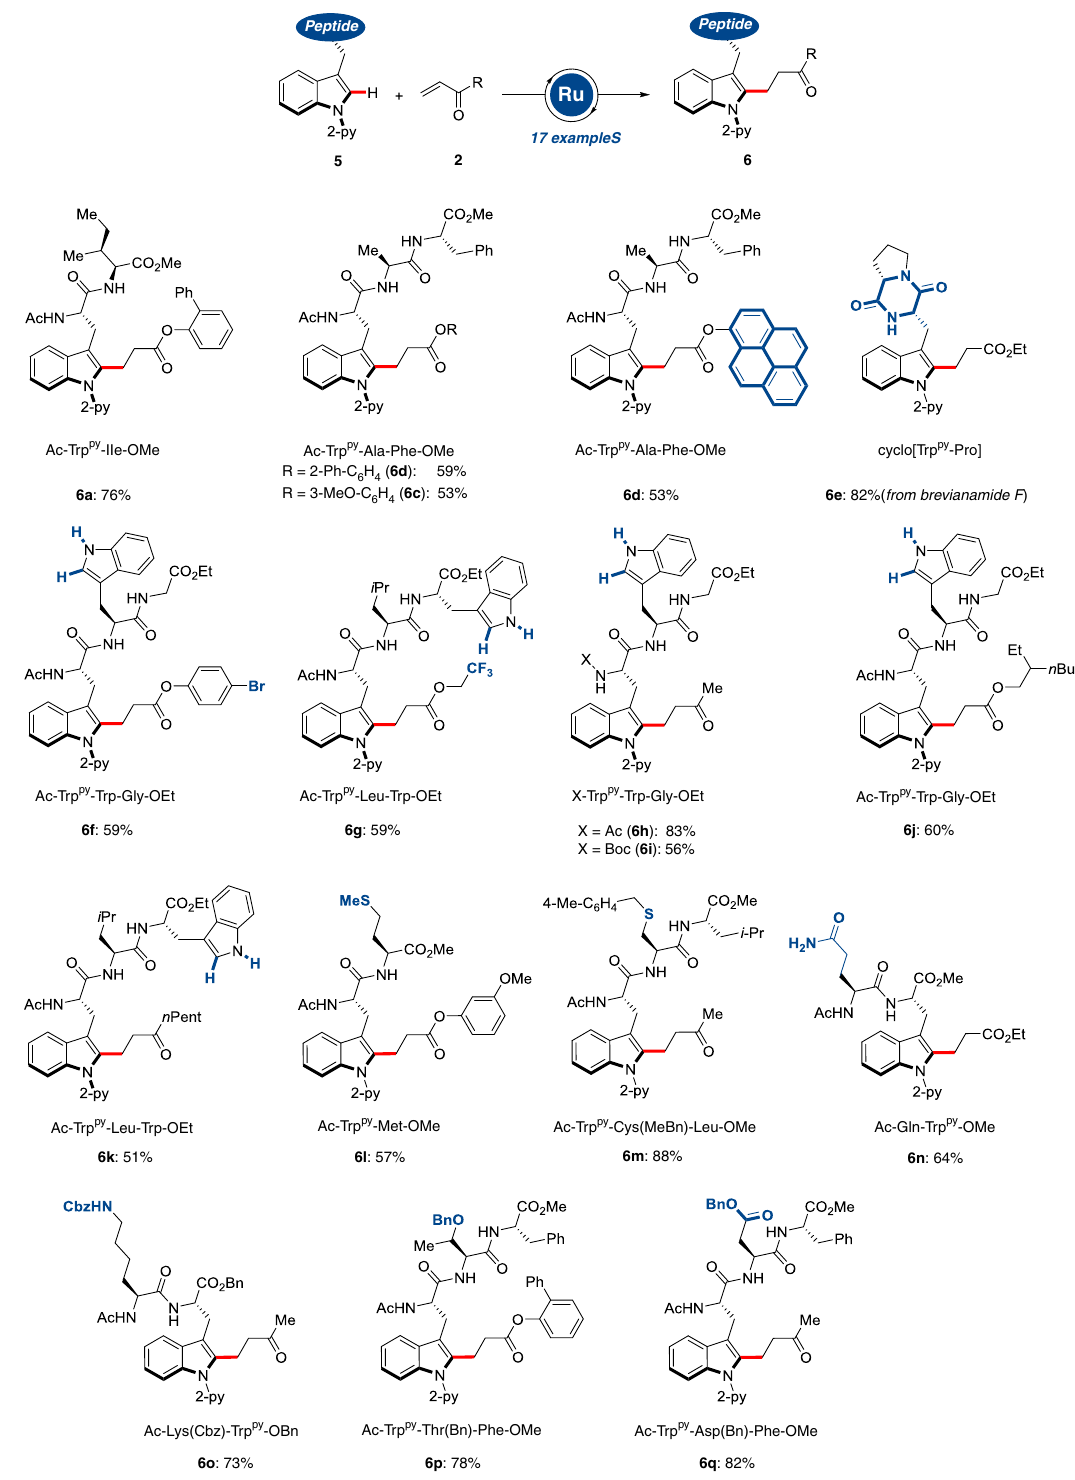
Fig. 4 Late-stage functionalization of peptides. Ruthenium(II)-catalyzed C – H alkylation of structurally complex peptides 5 with sensitive functional